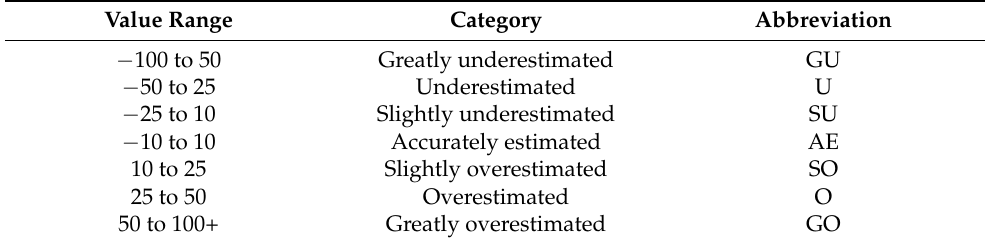
Table 4. The classification scheme for Relative Error Estimation